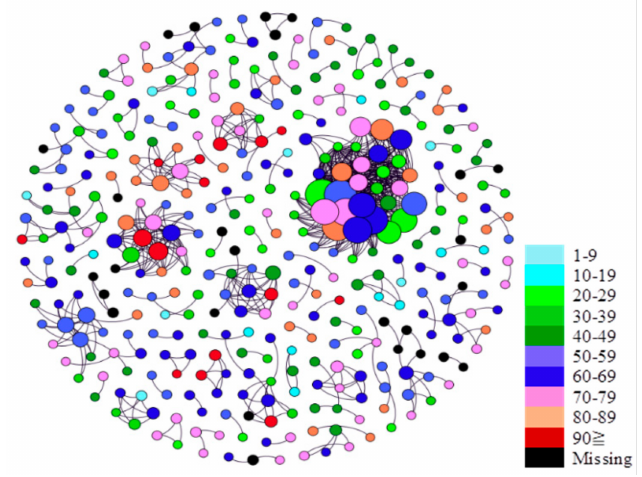
Figure 5. Viral transmission networks by age. Figure 6 present the asymptomatic status that each case belongs to in the networks. In the diagram, red circles correspond to asymptomatic cases, and blue circles correspond to symptomatic cases. The diagram suggests that although asymptomatic patients transmit the virus to others at a higher level, the infected individuals are also likely to be asymp- tomatic. This finding was confirmed by using descriptive statistics, which indicated that only 13% ( n = 39) of the individuals who were infected by symptomatic patients ended up being asymptomatic, whereas 53% ( n = 41) of the individuals who were infected by asymptomatic patients ended up being asymptomatic ( p <